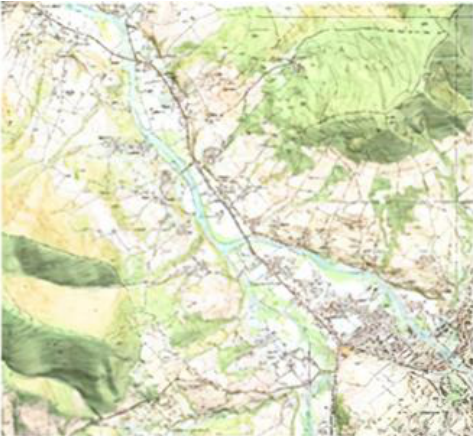
Figure 22. Textured DTM model — top view.